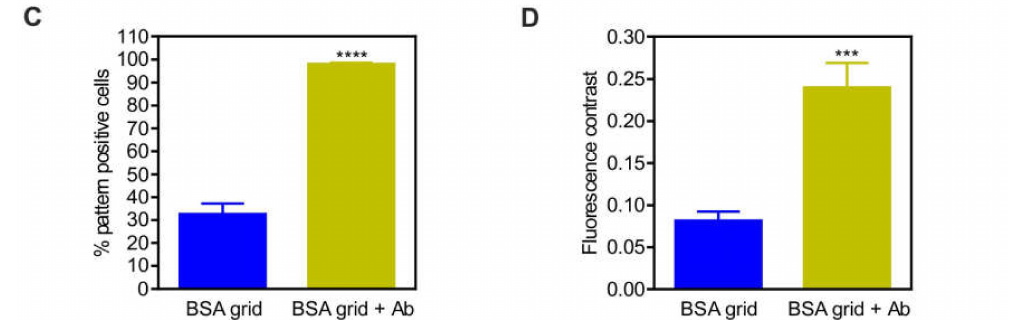
Figure 5. Specificity of prey protein copatterning. ( A ) Schematic illustrations of variations in the substrate-cell interface. ( B ) HeLa cells stably expressing Grb2-YFP were grown for at least 3–4 h on unmodified 1- µ m BSA grids (left) or on completely functionalized anti-EGFR antibody-coated surfaces (right). Ten minutes after EGF stimulation (170 nM), large-area surface scans were captured to deliver a representative snapshot of the Grb2-YFP distribution. Insets show enlarged areas of the overall scans. ( C ) Quantitation of the number of pattern-positive cells. ( D ) Quantitation of fluorescence contrast. Error bars are based on the mean ± SE of more than 300 cells. *** p < 0.05 and **** p < 0.001 for comparison of di ff erent levels of substrate functionalization. Graphical illustrations are not drawn to